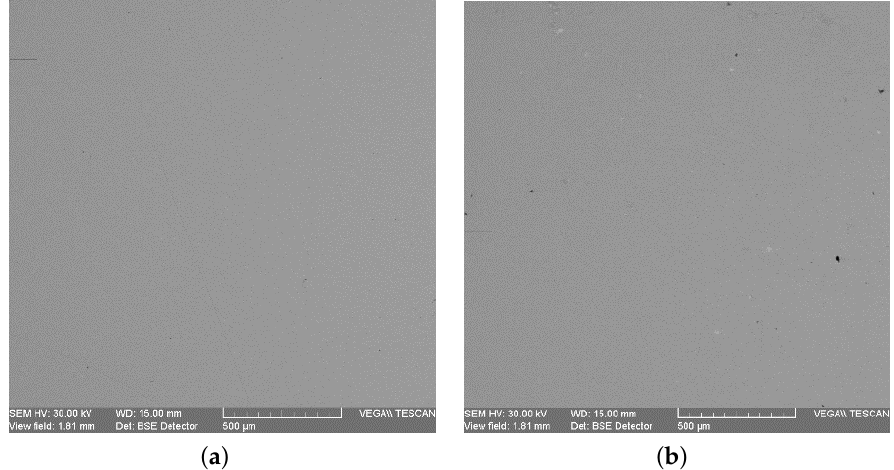
Figure 5. ( a , b ) SEM images of Ti 0.4 Hf 0.6 NiSn and (Ti 0.4 Zr 0.6 ) 0.7 Hf 0.3 NiSn pressed